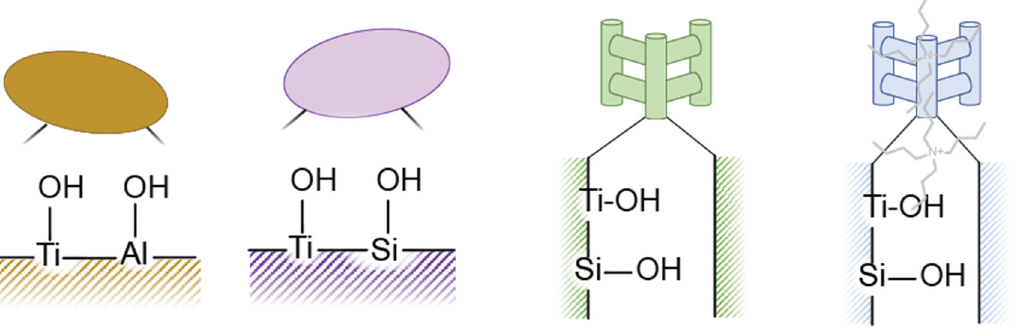
Figure 8. Schematic representation of (from left to right) TiO 2 - γ -Al 2 O 3 , TiO 2 -SiO 2 , TS-1 and TS-1U. Shown in Figure 9 are representative Bright-Field TEM (BF TEM) and HAADF-STEM images of the gold catalysts supported on different TiO 2 -based supports. The gold parti- of the Au catalysts. The PZC of the Ti-modified supports was lower than for pristine γ - Al 2 O 3 and SiO 2 (Table 2), which is indicative for the formation of acidic tetrahedral Ti 4+